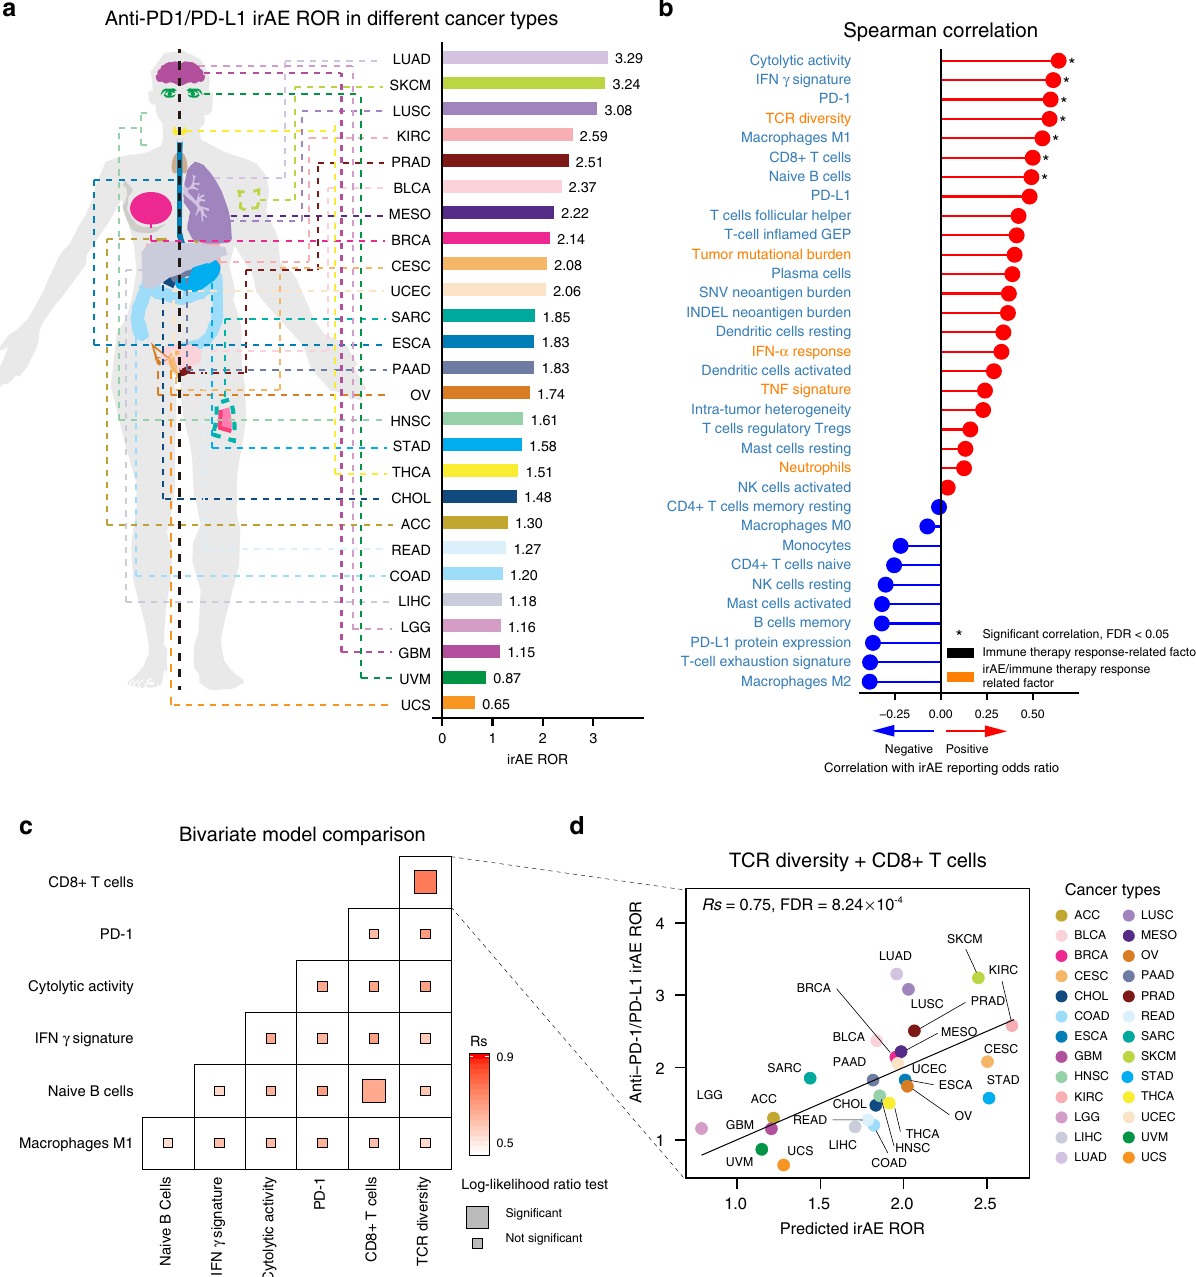
Fig. 1 Evaluation of the association between irAE and related factors. a Anatomic sites of cancer types (left panel), and irAE ROR across 26 cancer types (right panel). b Spearman correlation between irAE ROR and 36 factors for positive correlation (red lollipop) and negative correlation (blue lollipop). * indicates signi fi cant correlation (FDR < 0.05); cytolytic activity FDR = 0.01, Interferon (IFN) γ signature FDR = 0.01, PD-1 FDR = 0.01, T-cell receptor (TCR) diversity FDR = 0.01, macrophages M1 FDR = 0.03, CD8 + T cells FDR = 0.05, naive B cells FDR = 0.05; irAE and immune therapy response-related factors are marked in orange. c Comparison of performance of bivariate models in predicting irAE for all combinations of six signi fi cantly correlated variables. Spearman R ( Rs ) was calculated between predicted and observed irAE ROR. The shade of the square indicates the Rs , and the size indicates the signi fi cance of the log-likelihood ratio test. d Combined effect of TCR diversity and CD8 + T-cell bivariate model (Spearman correlation, Rs = 0.75, FDR = 8.24 × 10 − 4 ). The equation of the bivariate model is 0.31 × TCR diversity + 8.87 × CD8 + T cells + 0.27. irAE immune-related adverse events, ROR reporting odds ratio, FDR false discovery rate, LUAD lung adenocarcinoma, SKCM skin cutaneous melanoma, LUSC lung squamous cell carcinoma, KIRC kidney renal clear cell carcinoma, PRAD prostate adenocarcinoma, BLCA bladder urothelial carcinoma, MESO mesothelioma, BRCA breast invasive carcinoma, CESC cervical squamous cell carcinoma and endocervical adenocarcinoma, UCEC uterine corpus endometrial carcinoma, SARC sarcoma, ESCA esophageal carcinoma, PAAD pancreatic adenocarcinoma, OV ovarian serous cystadenocarcinoma, HNSC head and neck squamous cell carcinoma, STAD stomach adenocarcinoma, THCA thyroid carcinoma, CHOL cholangiocarcinoma, ACC adrenocortical carcinoma, READ rectum adenocarcinoma, COAD colon adenocarcinoma, LIHC liver hepatocellular carcinoma, LGG brain lower-grade glioma, GBM glioblastoma multiforme, UVM uveal melanoma, UCS uterine